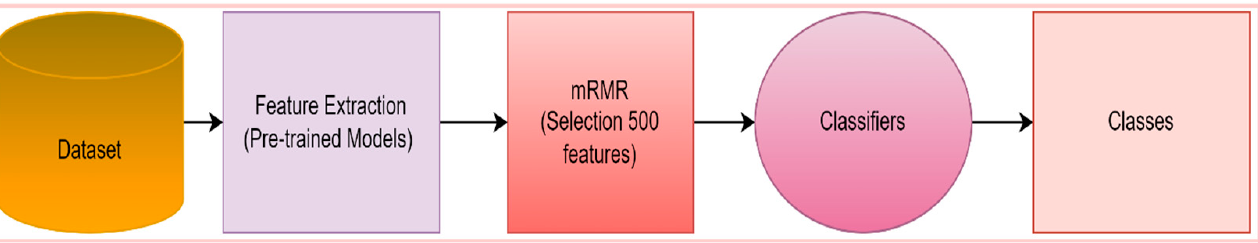
Figure 6. Flowchart of Pre-trained models + mRMR + classifiers.